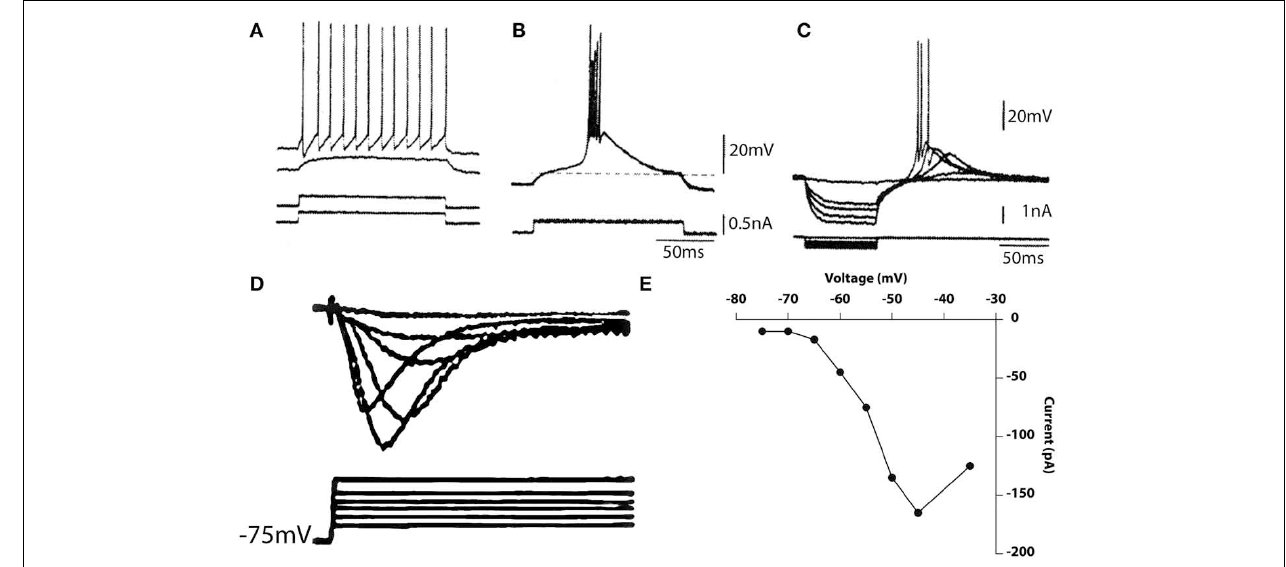
FIGURE 9 | Electrophysiological properties of thalamic cells recorded in vitro . (A,B) Depolarizing current pulses (bottom traces) elicited no response when delivered from the resting potential, tonic firing when delivered from a depolarized potential (A) and a burst response when